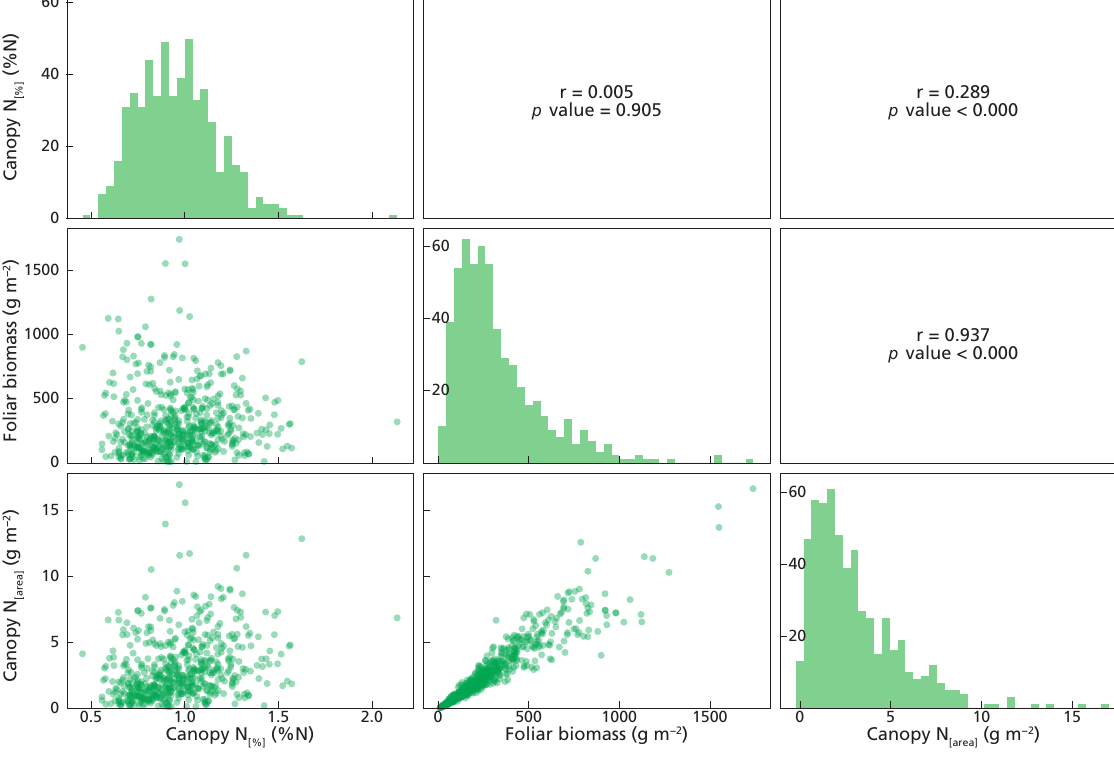
Figure A4. The upper right part of this figure shows the Pearson correlation matrix between canopy N [ % ] (%N), canopy N [ area ] (gm − 2 ) and foliar biomass (gm − 2 ) variables for evergreen needleleaf forest (ENF) plots, n = 563. The diagonal presents the histogram of the variable on the x axis, while the y axis represents the number of counts. The lower left part of this figure represents the scatterplots between the variables.